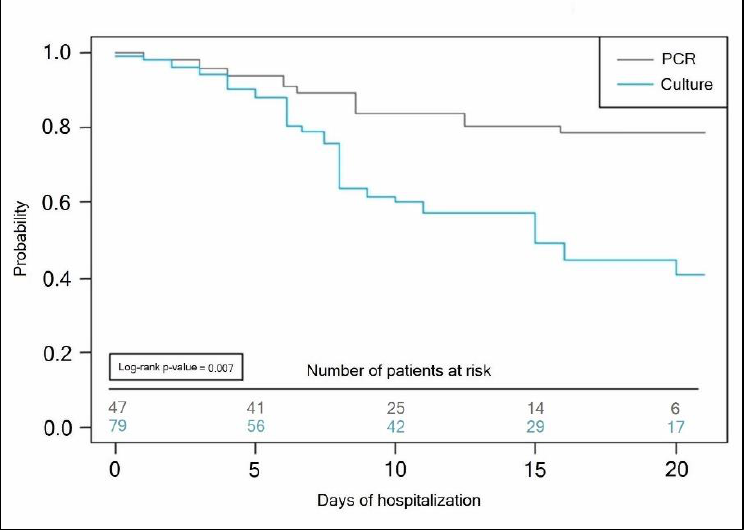
Figure 4. Kaplan–Meyer probability curve of hospitalization duration by the method of bacterial identification test employed in patients self-medicating with antibiotics.